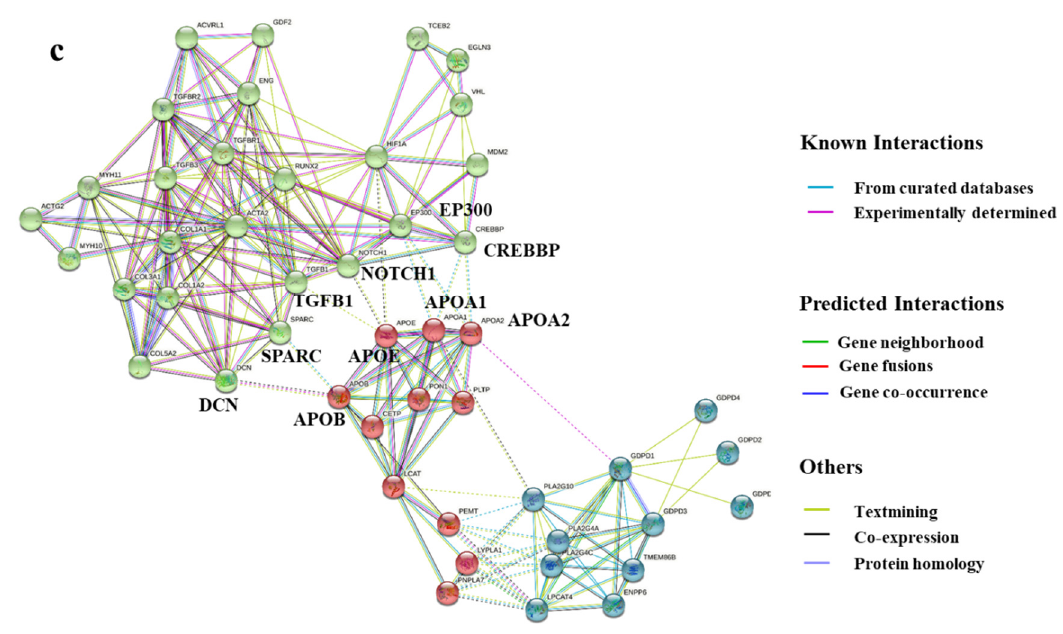
Figure 6. ( a ) Expression of metastasis-related metabolites in the plasma of clinical BC patients, (* p < 0.05, ** p < 0.01), (N0: n = 14; N1: n = 8; N2 or N3: n = 10) ( b1 , b2 ) LCAT ( b1 ) and GDPD1 ( b2 ) expressions in BC compared with normal control, (*, p < 0.01). ( c ) LCAT, GDPD1, TGFB1, HIF1A, COL1A1, ACTA2, and ENG proteins interaction networks in STRING database.